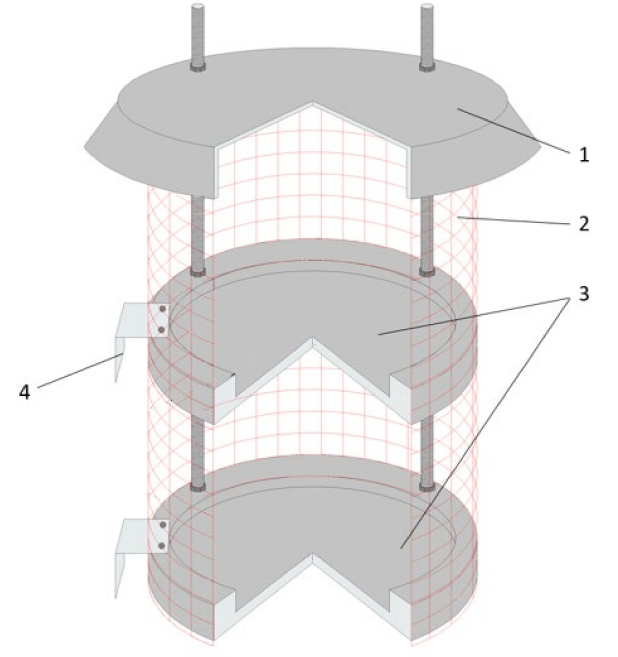
Figure 2. Passive sampler for particulate matter. Roof (1), protective net (2), collection plates (3), fixing bracket